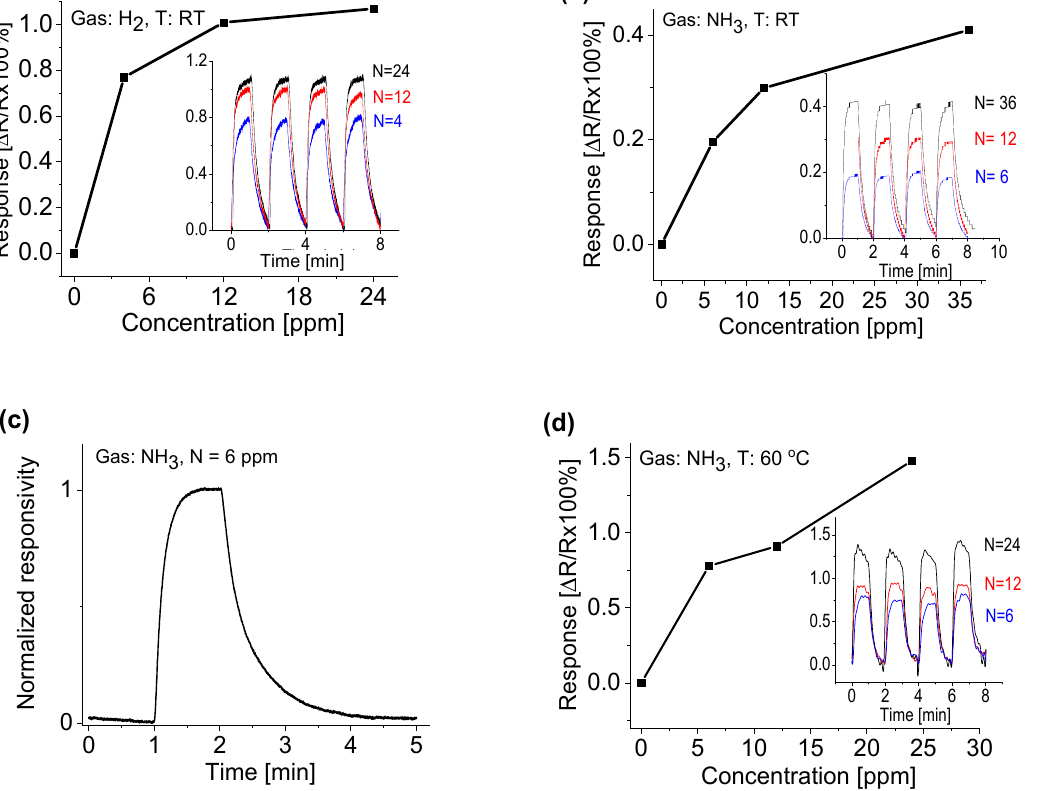
Figure 6. The response strengths of the prototype to ( a ) H 2 , ( b ) ammonia gas at room temperature, ( c ) as a function of time, and ( d ) at 60 °C. The bias of 1 V remained unchanged for all cases. Inset: the response as a function of time at different concentrations (N) in ppm.